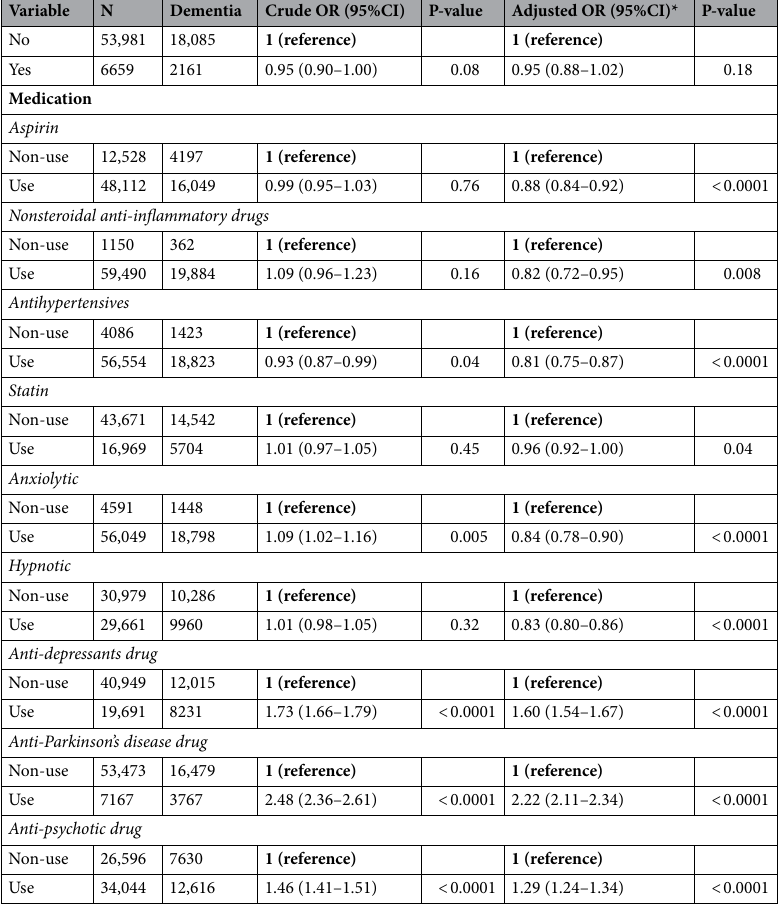
Table 2. Risk of dementia with prior use of bladder antimuscarinic drugs, other medications, and comorbidities. OR odds ratio. *Adjusted for age, sex, all comorbidities, all medications, other anticholinergic